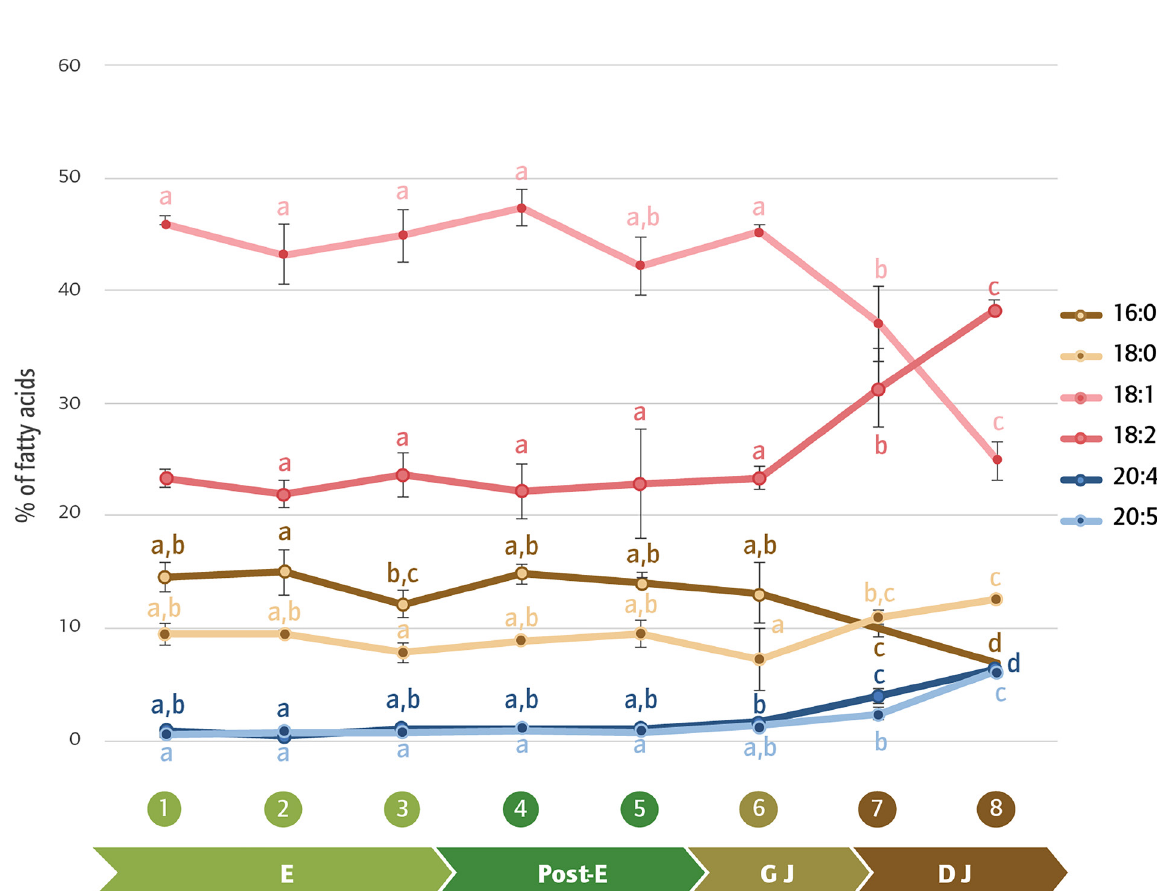
Figure 11. Composition of the major fatty acids during P. pythagoricus development: palmitate (16:0), stearate (18:0), oleate (18:1), linoleate (18:2), eicosatetraenoic acid (20:4) and eicosapentaenoic acid (20:5). The values are the percentage means ± SDs. Different letters indicate significant differences among the different stages at a p < 0.05, as determined by Tukey’s post hoc test. 1 to 8: stages of P. pythagoricus development; E: embryonic period; Post-E: post-embryonic period; GJ: juveniles in gregarious stage; DJ: juveniles in dispersal